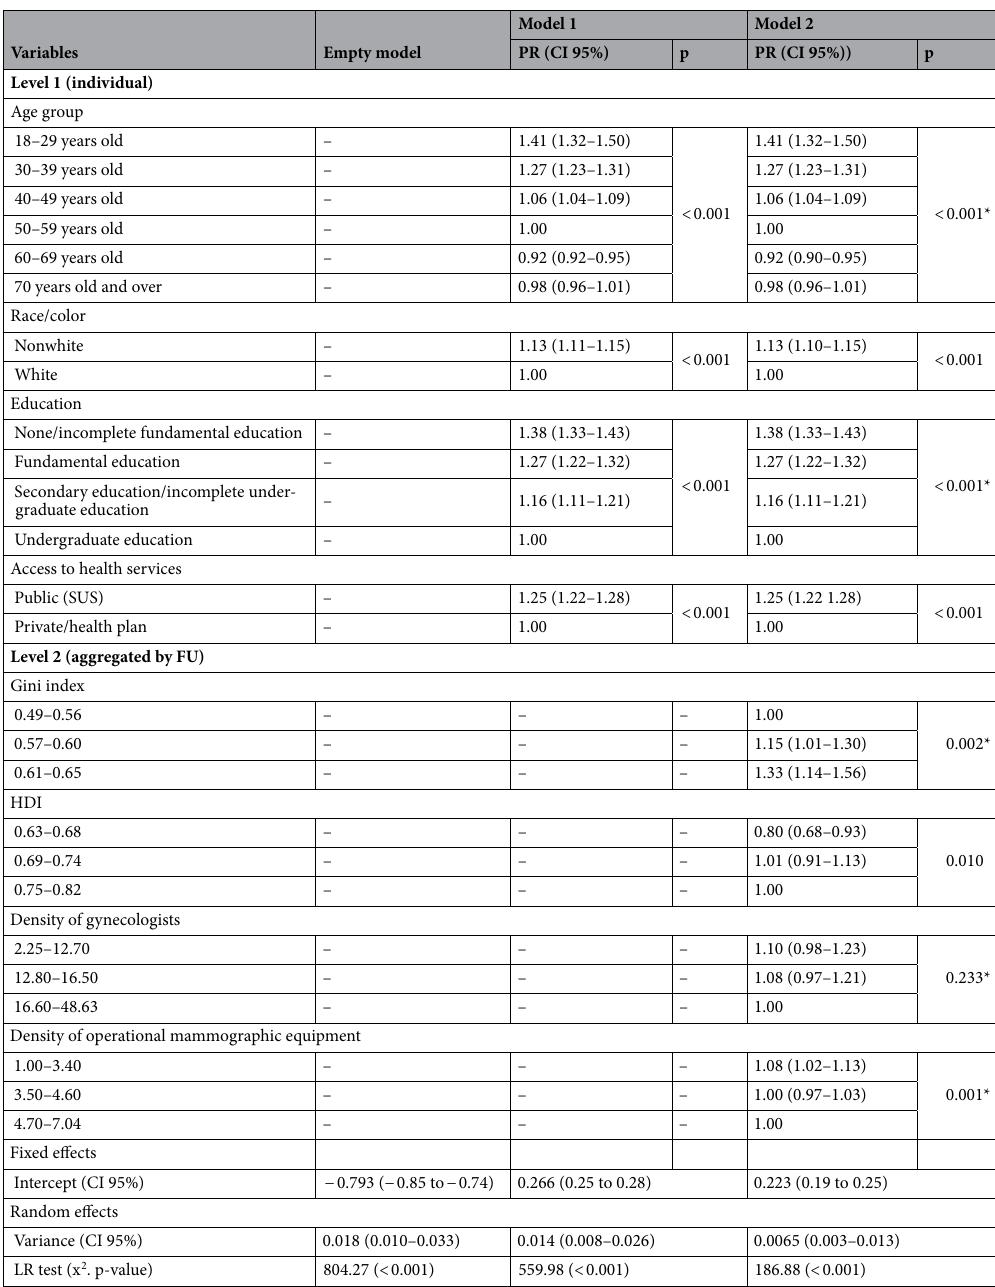
Table 2. Multilevel analysis between individual, socioeconomic contextual, and health service offer-related variables and advanced breast cancer staging in women between 18 and 99 years old, in the period 2006–2015. Brazil, per FU, except SP (n = 131,858). Model 1: Statistical model with inclusion of individual level variables; Model 2: Statistical model with inclusion of variables of individual level and contextual level per FU. PR prevalence ratio adjusted by the multilevel model with random intercept, CI confidence interval, p Wald’s test. * p trend ≤